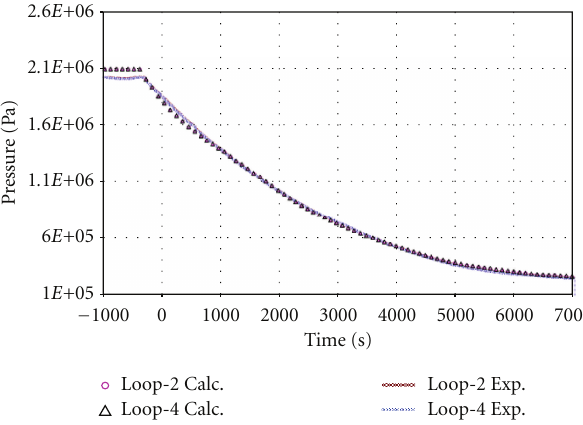
Figure 12: Run-2: Cold and hot leg temperature evolution in the active loops.